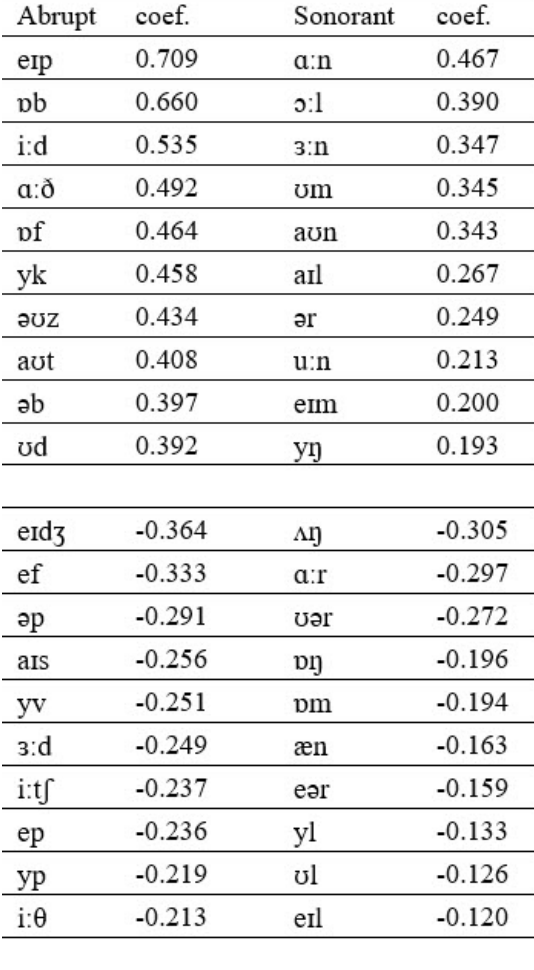
Table 3. The VC-biphones assigned with the ten top positive and negative coeffi - cients by